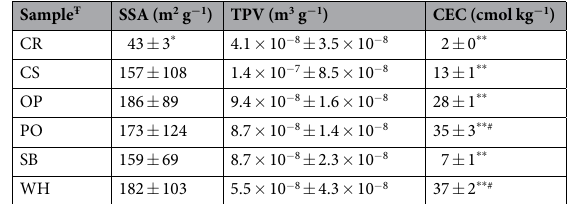
Table 1. Specific surface area (SSA), total pore volume (TPV), and cation exchange capacity (CEC) of samples of biochar from different sources. Ŧ CR = charcoal fines; CS = coconut shell; OP = orange peel; PO = palm oil bunch; SB = sugarcane bagasse; WH = water hyacinth. Anova post-hoc Tukey test ( * p < 0.1 or ** p < 0.01) . # samples PO and WH are not different between them (p > 0.01).